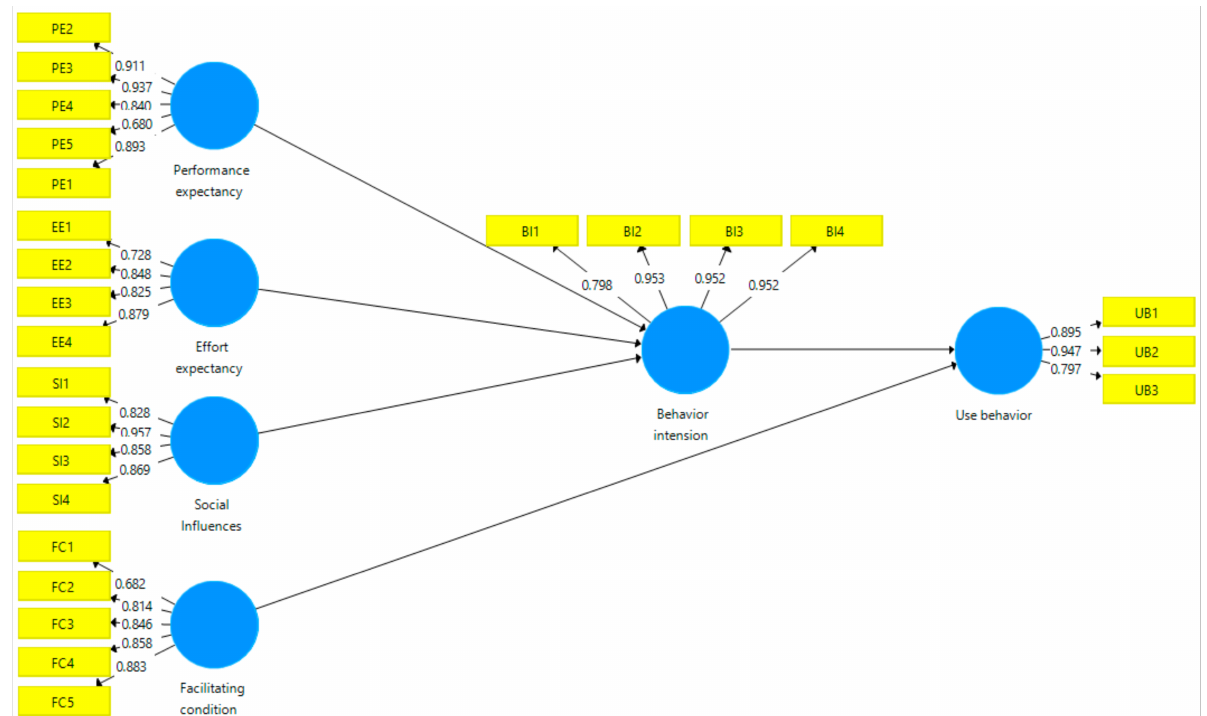
Figure 2. Result path model.